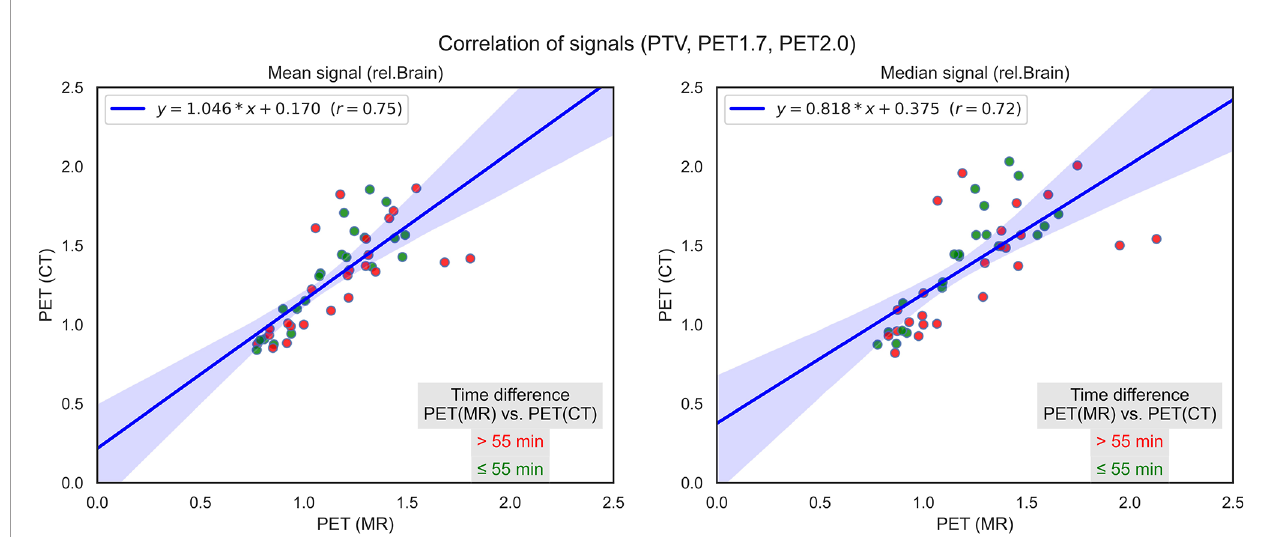
FIGURE 1 | Correlation of PET/CT and PET/MR signals regarding PTV, 18F-FDOPA T/N 1.7, and 18F-FDOPA T/N 2.0 volume indicating the time difference between the two